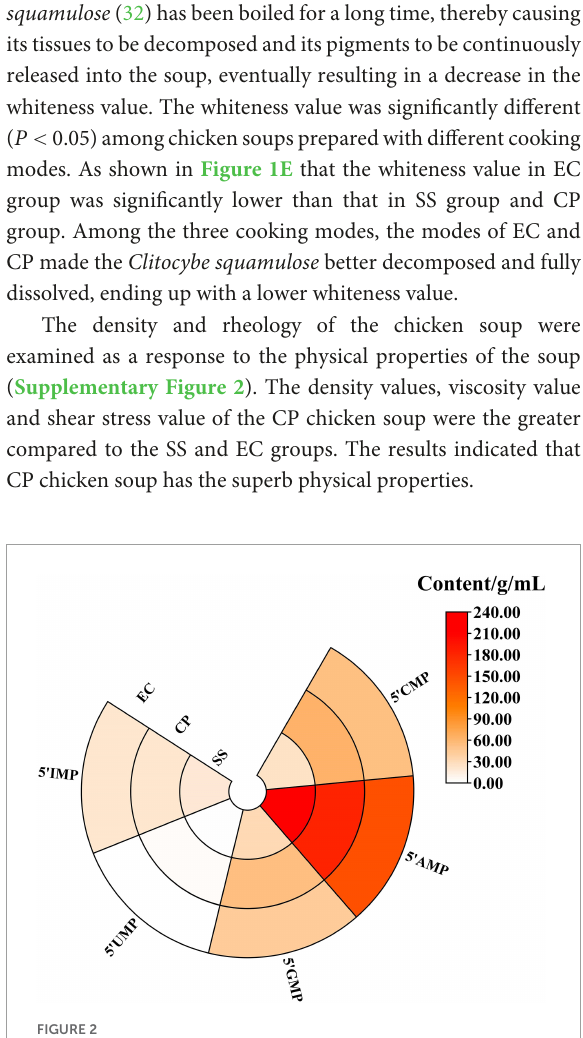
FIGURE2 Effect of cooking mode on 5 (cid:48) -nucleotides of Clitocybe squamulose chicken